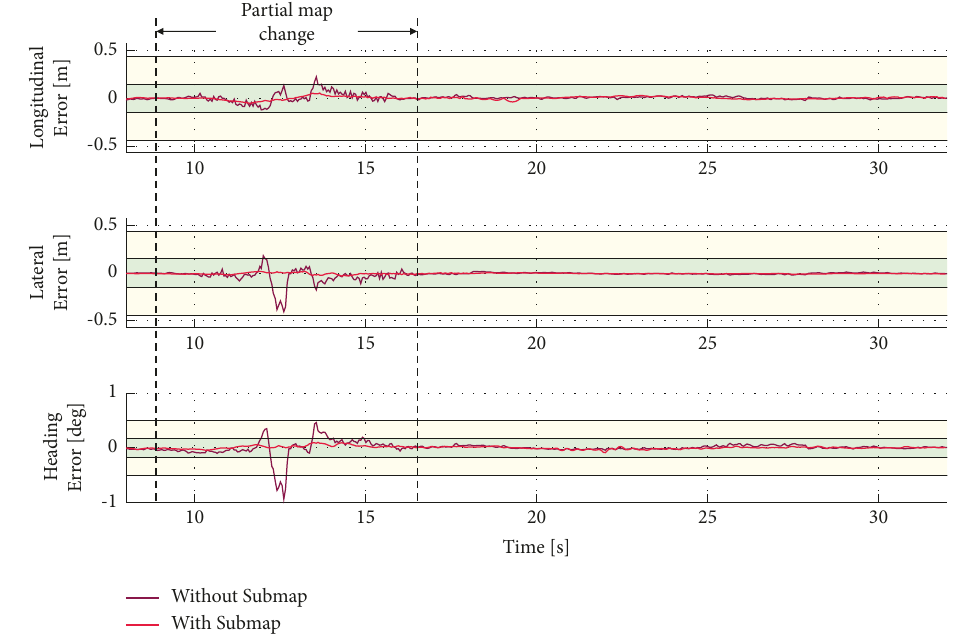
Figure 15: Performance of robust localization in map-changing simulations. Table 2: Table of robust localization performance in simulations.